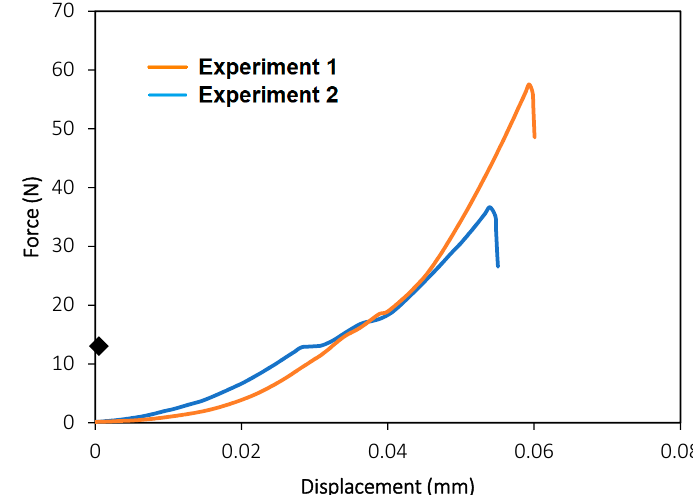
Figure 2. Results of the compression test for two pellets of the same ZSM-5 extrudate sample. (The solid symbol represents the crushing force for a commercial 4A zeolite extrudate, reported for comparison [9]).